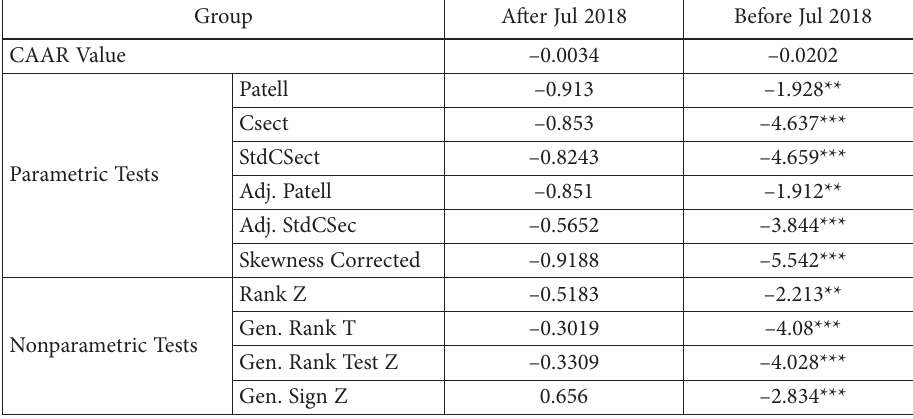
Table 5. Results of grouping the announcements by period (source: own design)